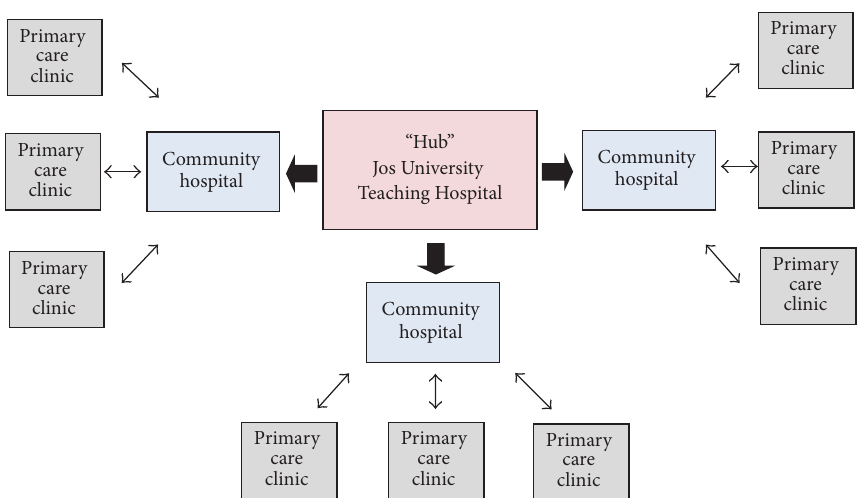
Figure 2: The Plateau State Decentralization Initiative’s “hub-and-spoke” model of decentralized care.